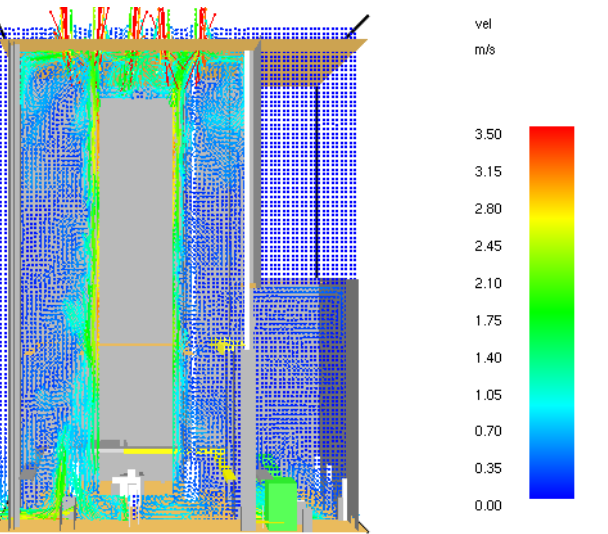
Figure 7. Distribution of air flows in the boiler house under regular operating conditions.